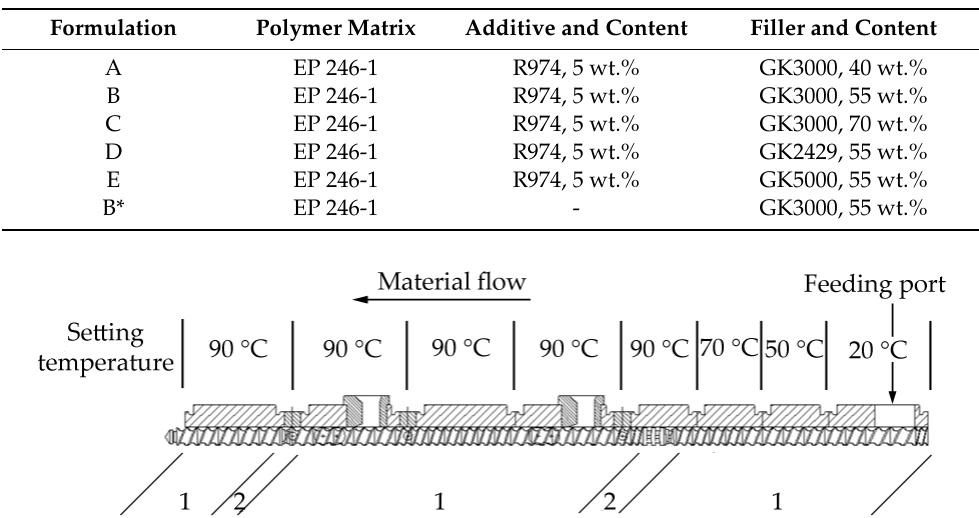
Table 2. Overview of components used in different formulations.